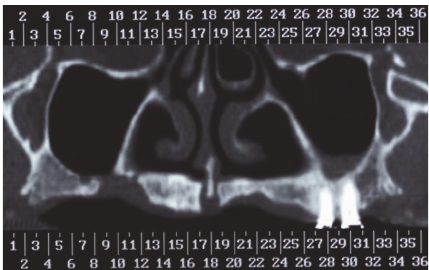
Figure 3: Computed tomography of maxilla. Distance between reconstructions: 3